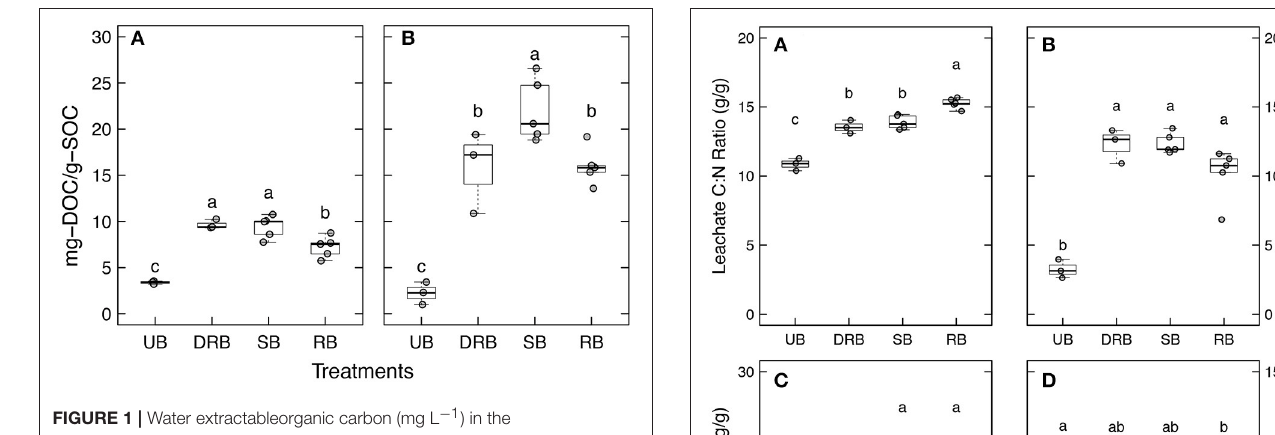
FIGURE 1 | Water extractableorganic carbon (mg L − 1 ) in the soil leachate from unburned (UB), dry rapidly burned (DRB), slowly burned (SB), and rapidly burned (RB) soil aggregates from (A) forest soil and (B) shrubland soil. Different letters represent significantly different means as determined from Tukey’s HSD Test ( P < 0.05).